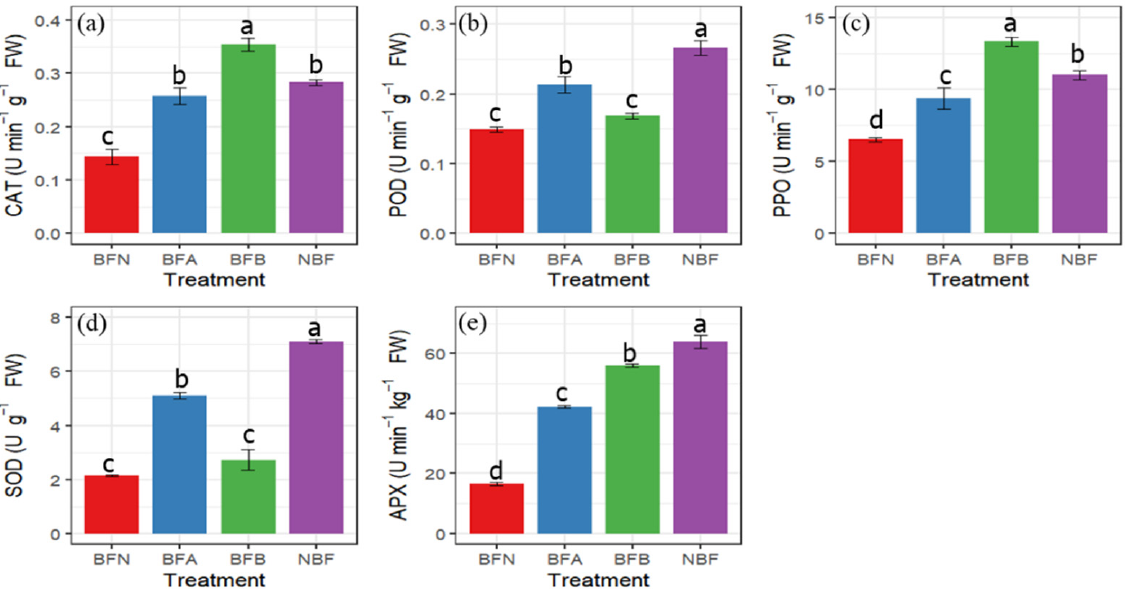
Figure 5. Effects of sunburn on the activities of enzymes. ( a ) Catalase (CAT), ( b ) peroxidase (POD), ( c ) polyphenol oxidase (PPO), ( d ) superoxide dismutase (SOD), and ( e ) ascorbate peroxidase (APX). Vertical bars are the mean ± SE ( n = 3). Different letters above the bars indicate significant differences at the 0.05 level by Duncan’s multiple range test.